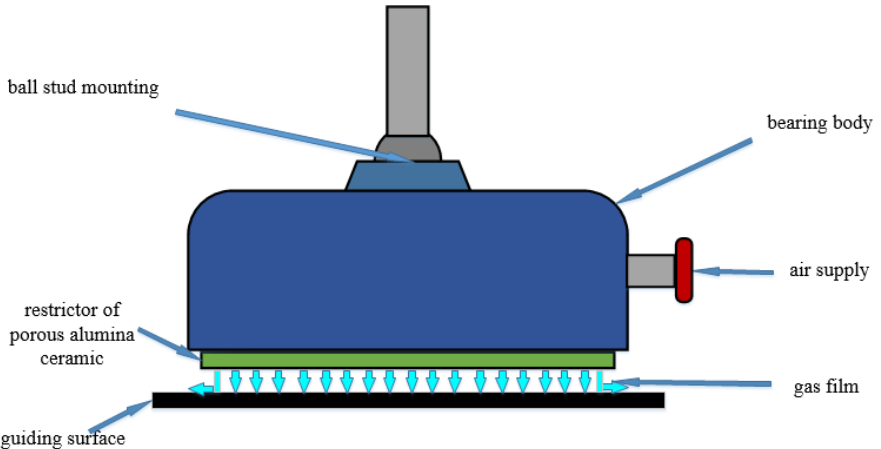
Figure 1. Principle of porous alumina ceramic membrane for the air bearing.